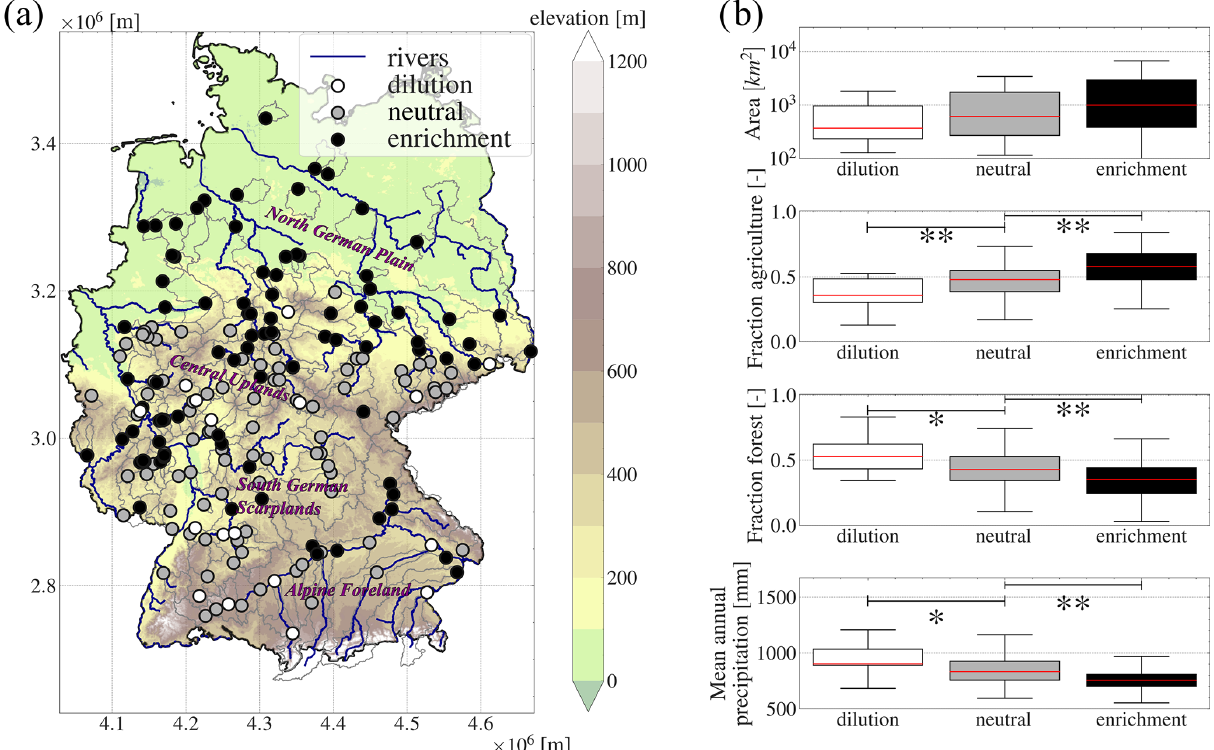
Figure 2. (a) Study area and stations of nitrate concentration measurements in stream water. Gray lines show catchment boundaries. Catch- ment outlets (points) are color-coded according to the long-term export pattern (dilution, neutral and enrichment). Blue lines show the main rivers. The background color map corresponds to the elevation. Purple labels indicate German natural regions. (b) Area, fraction of agri- culture, fraction of forest and mean annual precipitation of study catchments grouped according to export patterns (dilution, neutral and enrichment). Red lines show medians of boxplots and significance of median differences between adjacent boxplots was estimated using the Kruskal–Wallis test (displayed as ∗ for p < 0.05 and ∗∗ for p <